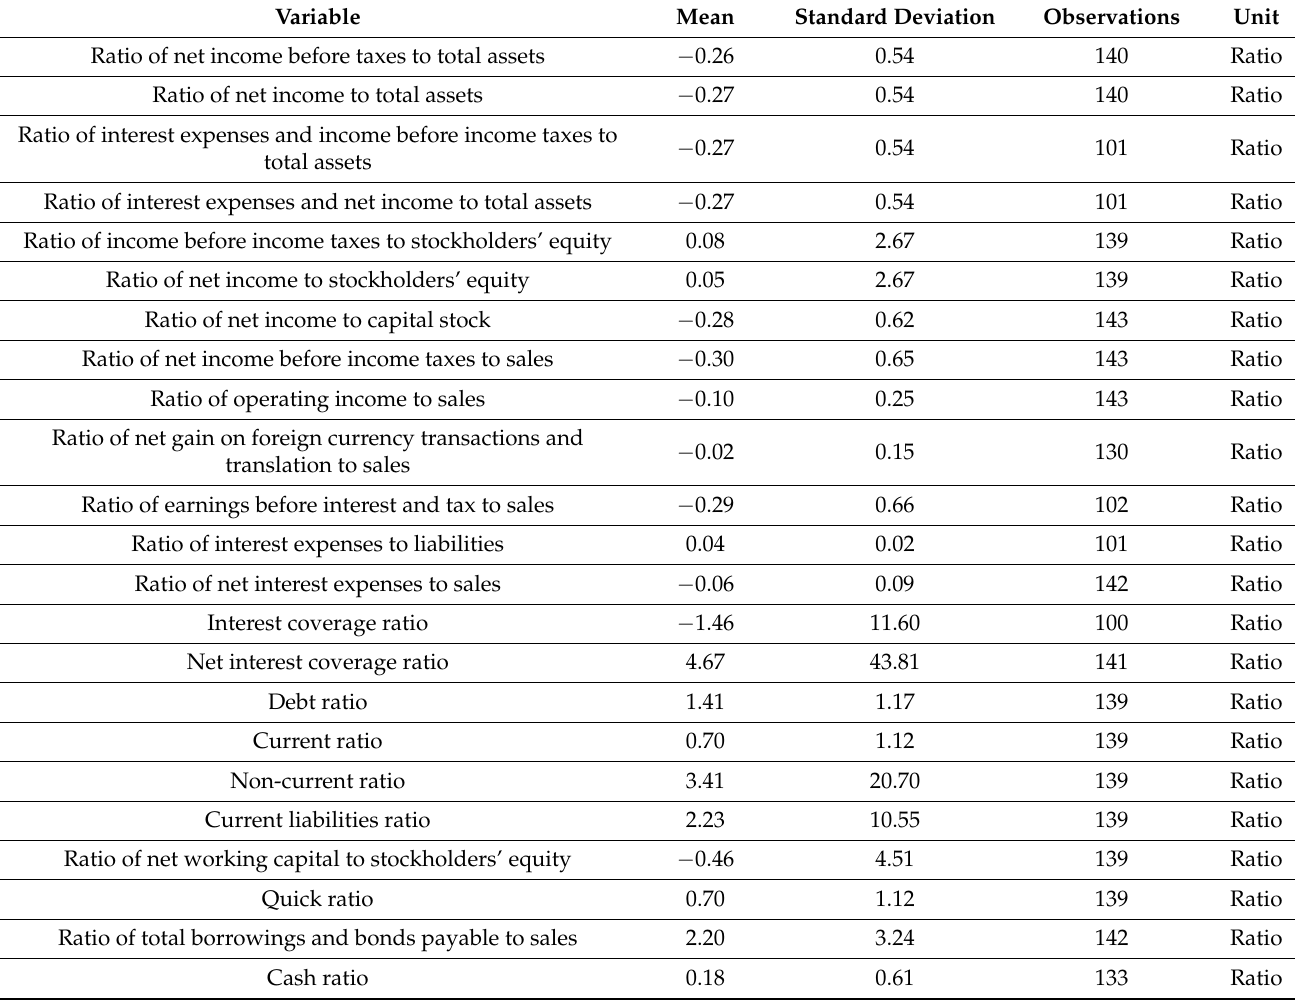
Table 5. Summary statistics of insolvent